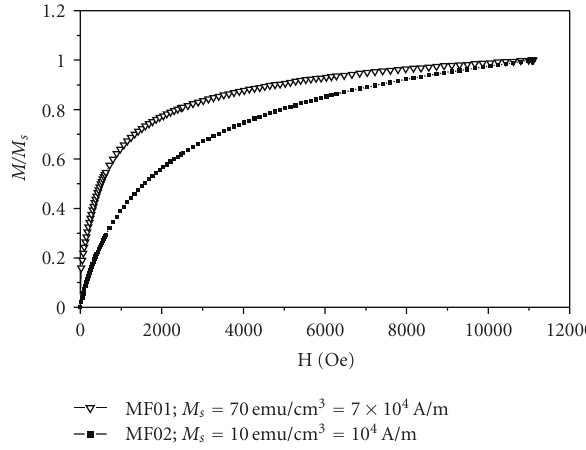
Figure 9: Reduced magnetization curves of water magnetic fluid samples prepared from 01 and 02